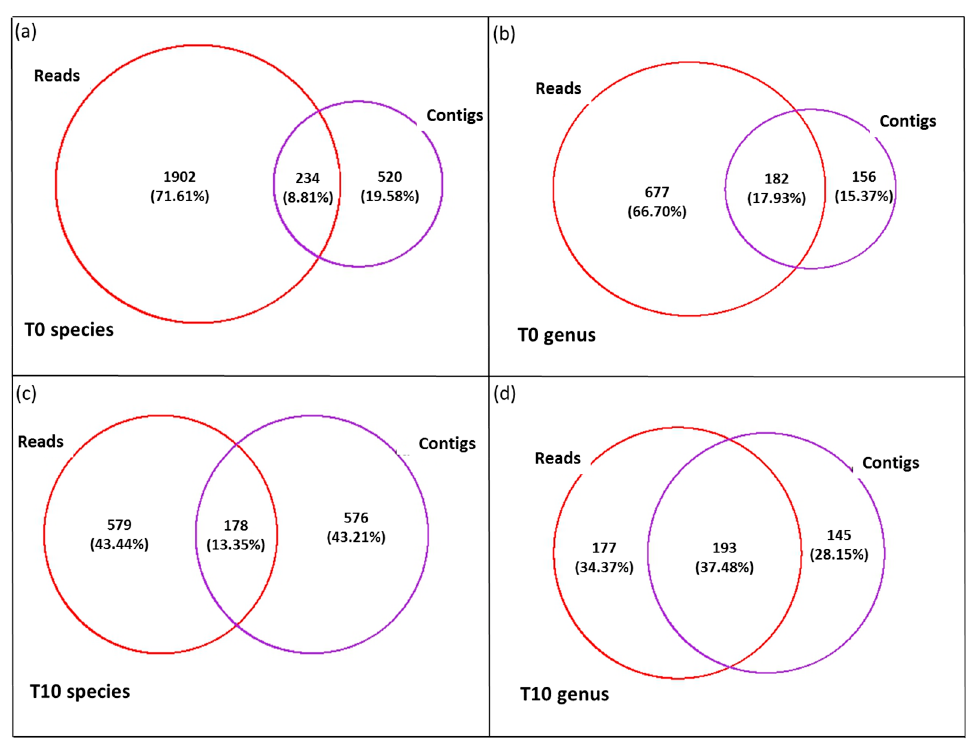
Figure 5. Presence–absence analyses of the <0.45 μ m fraction. Comparison of phylotypes at the level of species ( a , c ) and genus ( b , d ) using a subsample of reads (R1) versus contigs at T0 ( a , b ) and T10 ( c , d ).